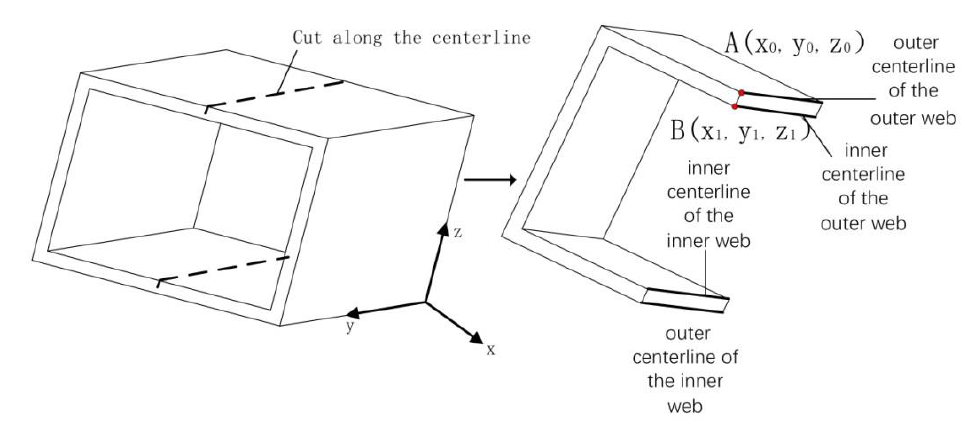
Figure 3. Sectional view of the rectangular profile along the profile.